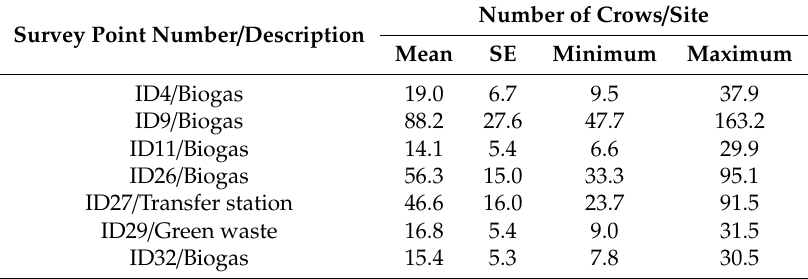
Table 3. Survey sites with high abundance of crows in the Vorarlberger Rhine Valley, Austria. All survey points where the mean number of crows observed ( Corvus corone and C. cornix ) exceeded 10 are listed. Values represent estimates from generalized linear model